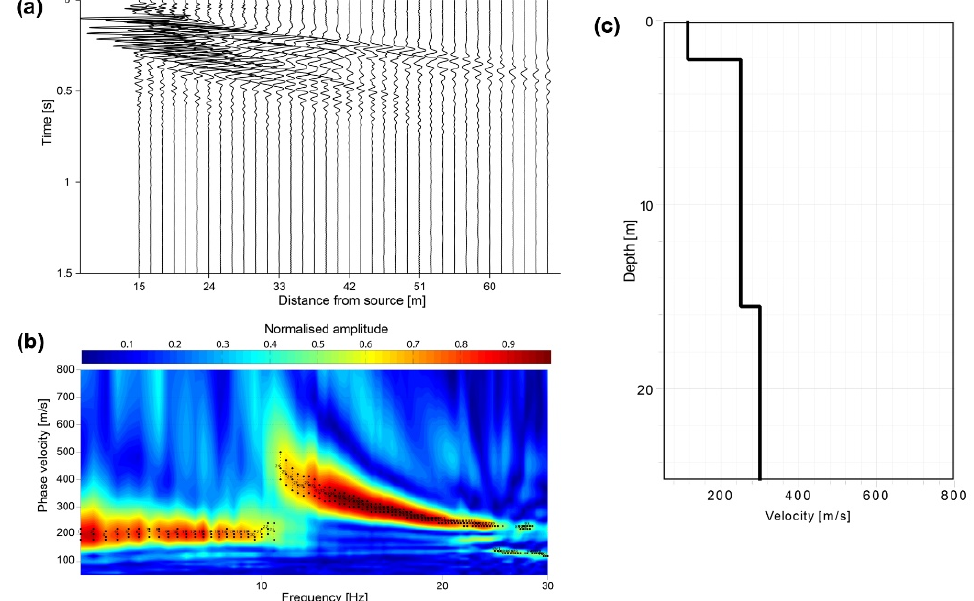
Figure 11. Multichannel analysis of surface waves (MASW) survey results: ( a ) shot-gather with source 15 offset; ( b ) dispersion image in the f–c domain with identification of both fundamental and first higher mode of Rayleigh wave; ( c ) best model Vs profile resulting from Rayleigh wave dispersion curve inversion.